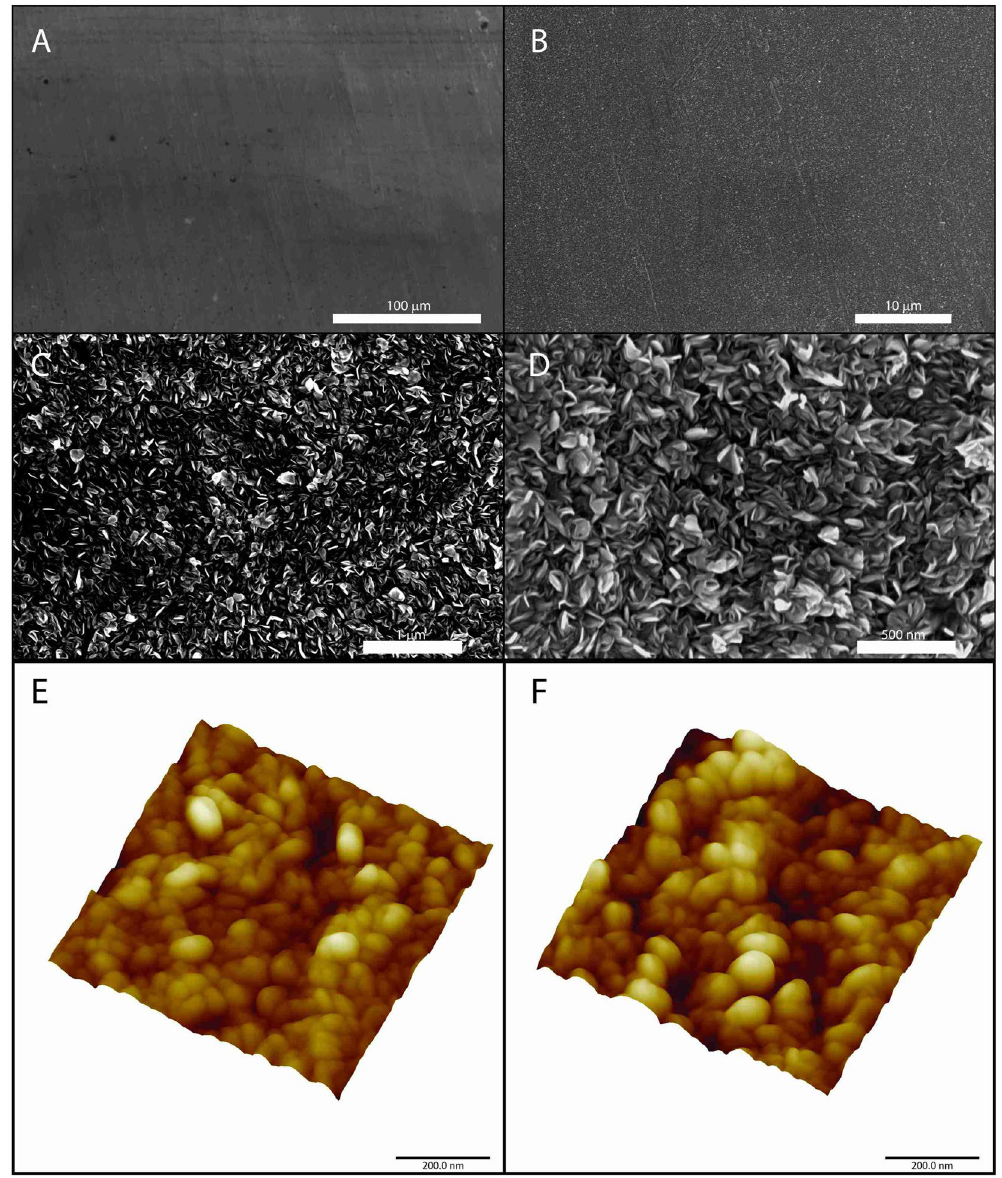
Figure 4. Scanning electron microscopy (SEM) ( A – D ) and atomic-force microscopy of VA-MoS 2 #1 ( E , F